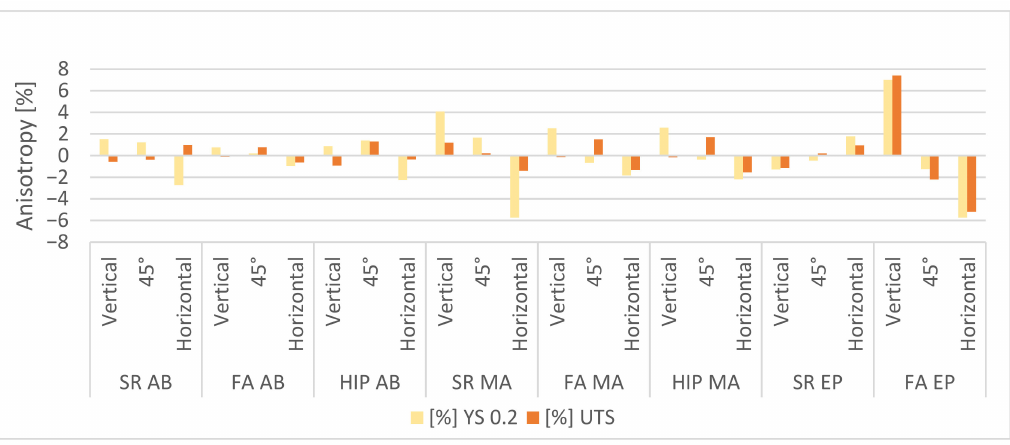
Figure 8. Directional anisotropy—tensile